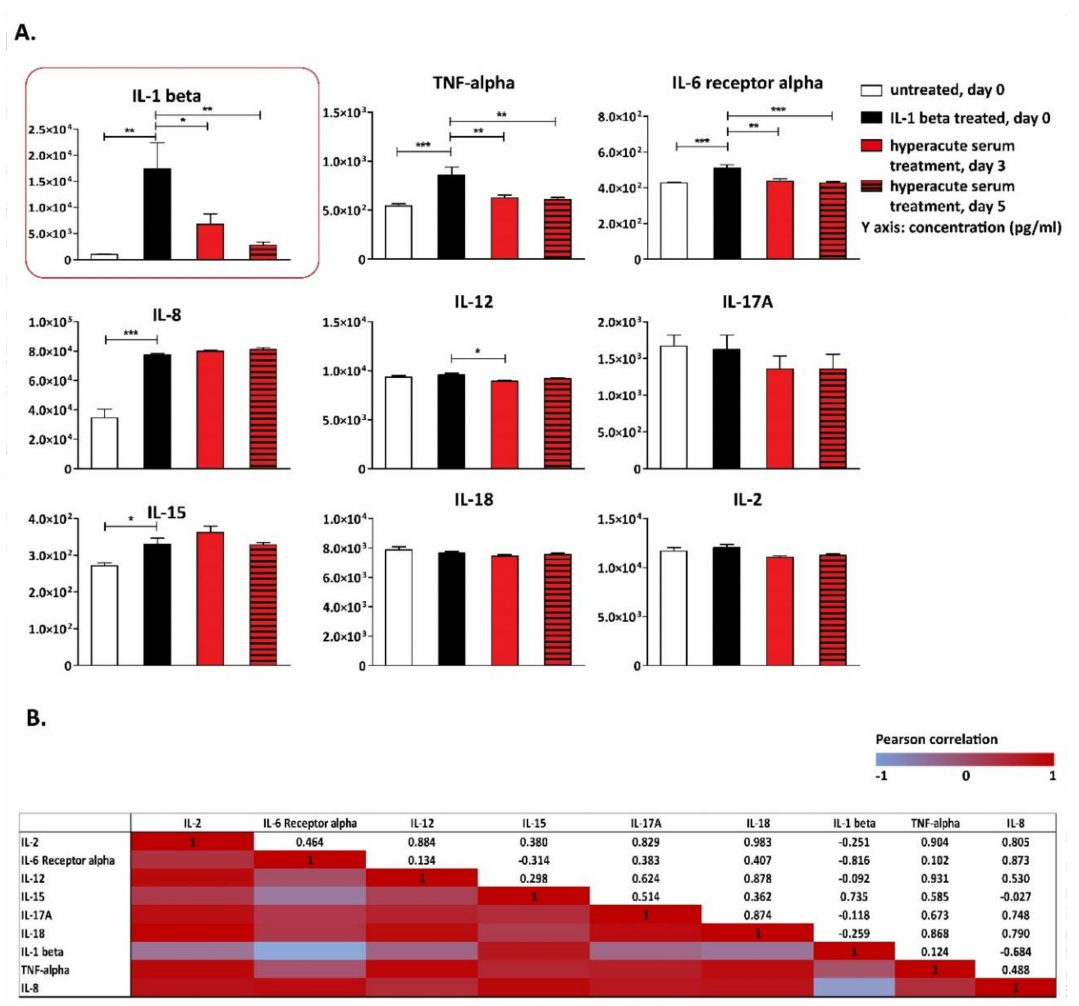
Figure 5. Main osteoarthritic inflammatory cytokines detected in the tissue culture supernatant. IL-1 β , IL-6R α , TNF- α , IL-8, and IL-15 significantly increased in response to IL-1 β stimulation. A significant decrease was observed in the concentration of IL-1 β and IL-6R α under the influence of hyperacute serum treatment on day 5. The pattern of TNF- α , IL-2, -12, -17, and -18 was the same; however, changes did not reach the significance level, n = 12. The significance level was p < 0.05, where * means that the p -value was between 0.05 and 0.01, ** means that p -value was between 0.01 and 0.001, and *** means that the p -value was lower than 0.001 ( A ). The correlations of cytokine changes are presented in heatmap tables. Between day 0 and day 5, the correlations were strong between IL-17, IL-12, and TNF- α , as well as between IL-8, IL-18, and TNF- α , while very strong correlations were found between IL-2 and IL-6R α , IL-8, IL-12, IL-15, IL-17A, IL-18, TNF- α , n = 12 ( B